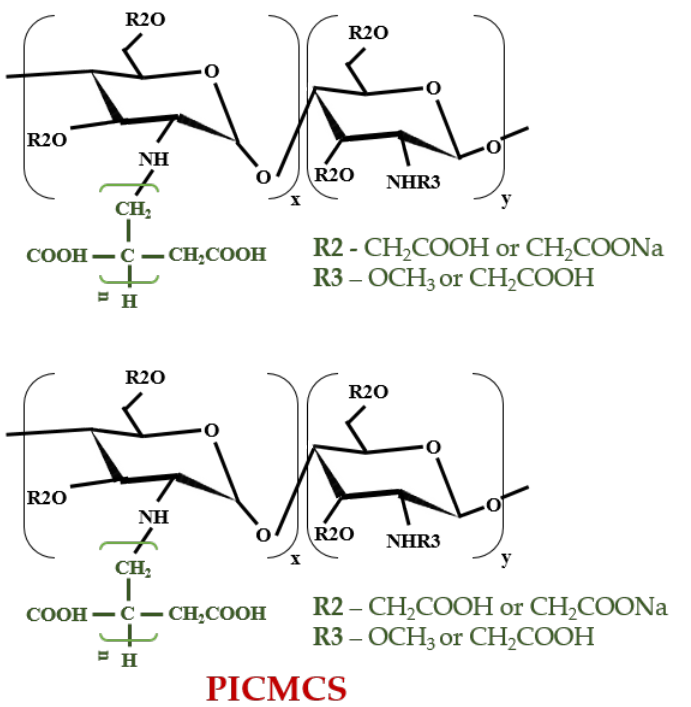
Figure 6. Carboxymethyl chitosan grafted with IA in drug delivery (adapted after [139]).